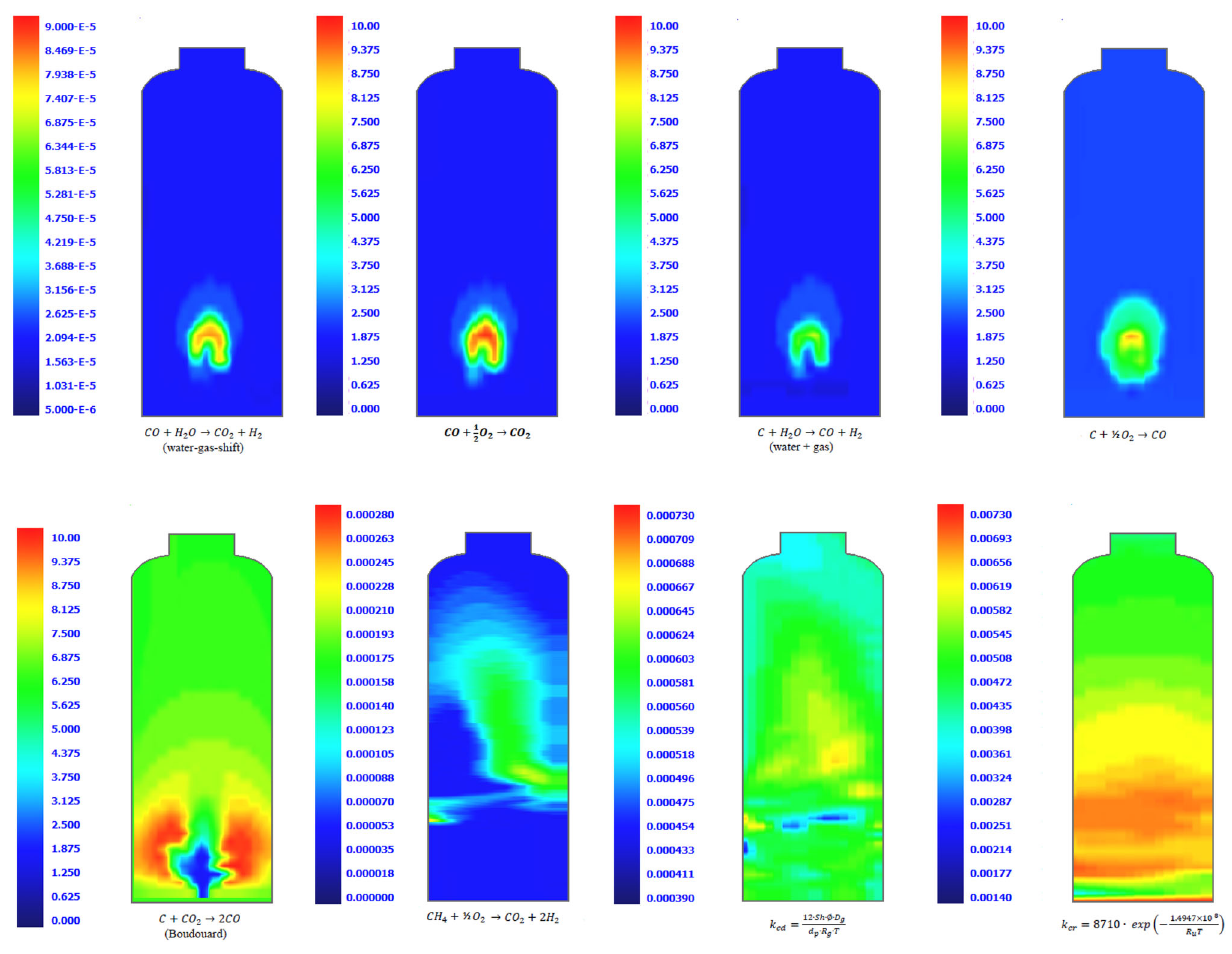
Fig. 8 Reaction rate contour in the gasifier